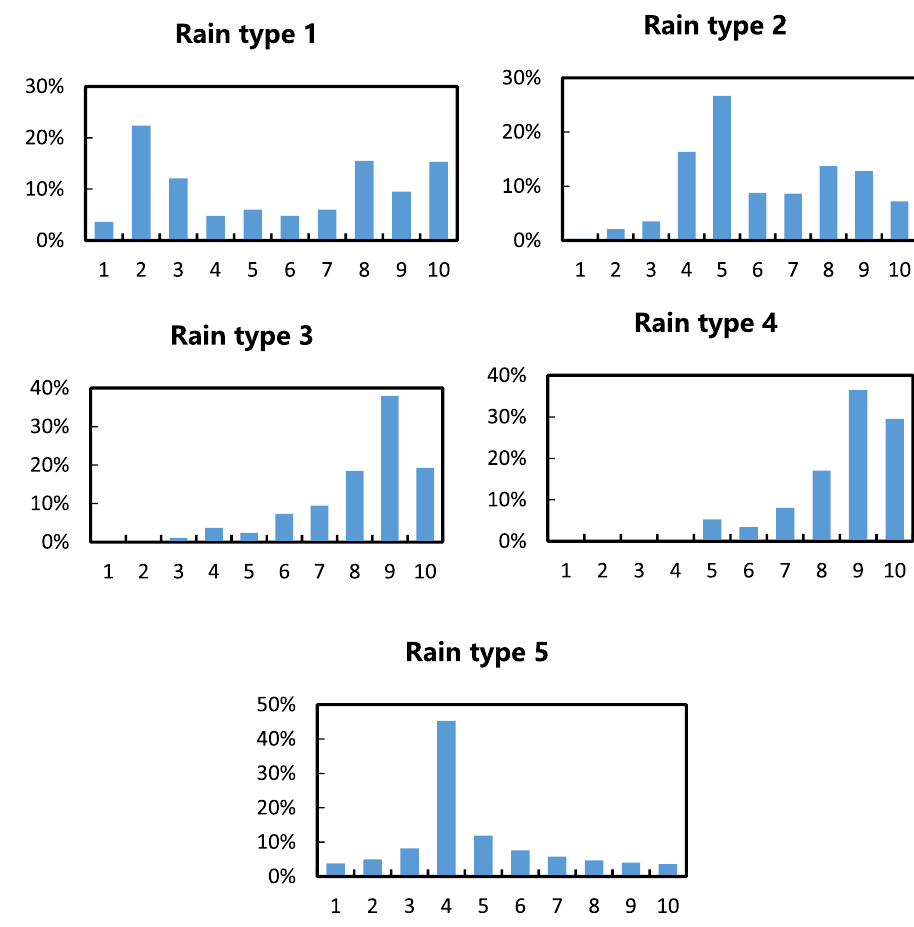
Fig. 5 Design rain patterns adopted for the study area on Jiefang South Road in Tianjin Municipality, China (% of rain in 3 hours, divided into 10